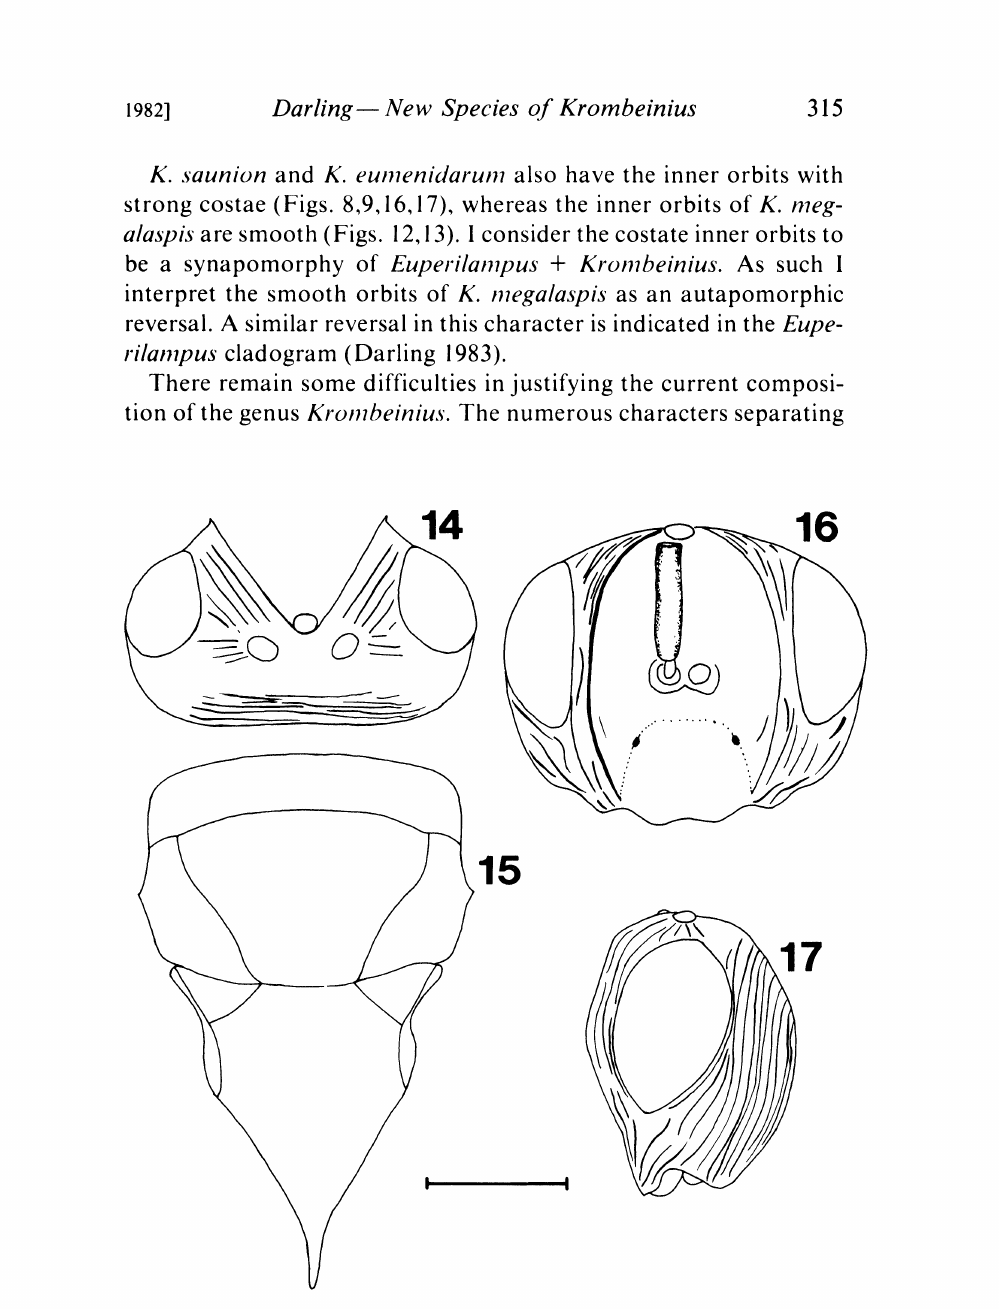
Figs. 14-17. Krontbeinius saunion. 14. Head, dorsal. 15. Mesosoma, dorsal. 16. Head, frontal. 17. Head, lateral. [Scale line